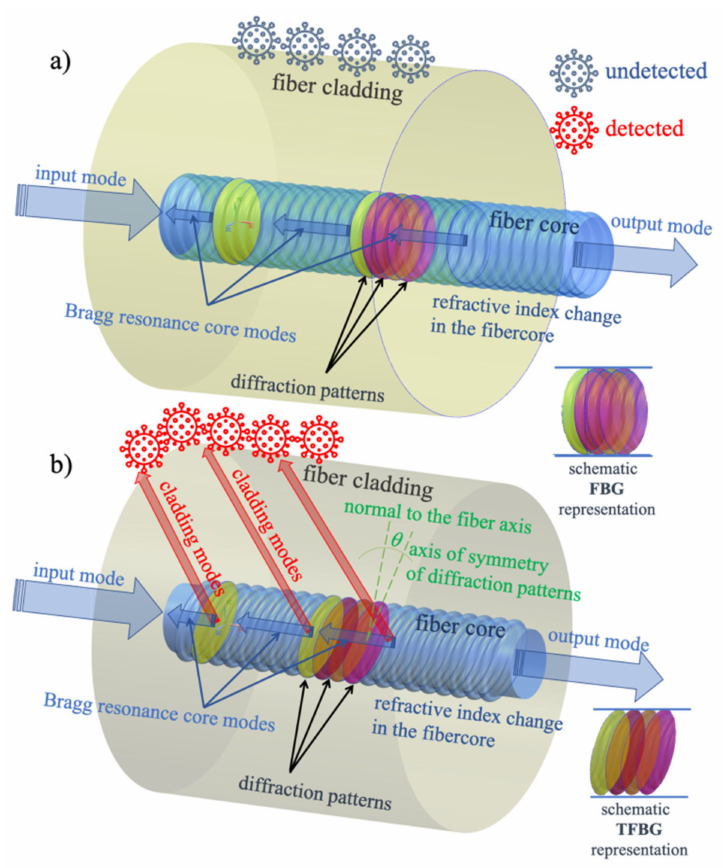
Figure 1. Comparison of the possibility of using FBG and TFBG in the detection of refractive index changes: ( a ) FBG, ( b )